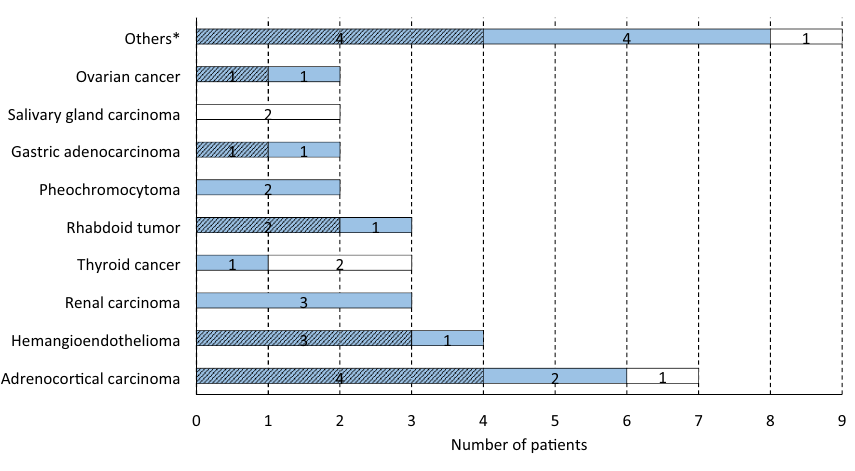
Figure 1. Distribution of the analyzed VRTs and survival status at 5 years across tumor types with regard to registration status. *The group “Others” comprised 9 single VRT types. Eight cases were registered: 4 patients (colorectal carcinoma, desmoplastic small round cell tumor, intestinal neuroendocrine carcinoma, follicular dendritic cell sarcoma) did not survive by 5 years, the other 4 (lip carcinoma, melanoma, pancreatic carcinoma, lung carcinoma) remained alive. One unregistered patient (uterine adenosarcoma) was alive at the same time point.